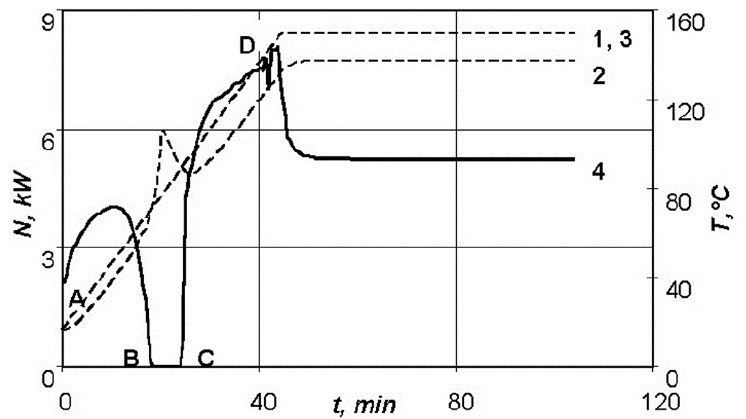
Figure 6. Dependences of parameters of the standard conditions of moulding of a package of 5 mm thick: 1 — temperature versus time on the lower surface of the product; 2 — temperature versus time on the upper surface of the product; 3 — temperature versus time for the theoretical conditions; 4 — power versus time.